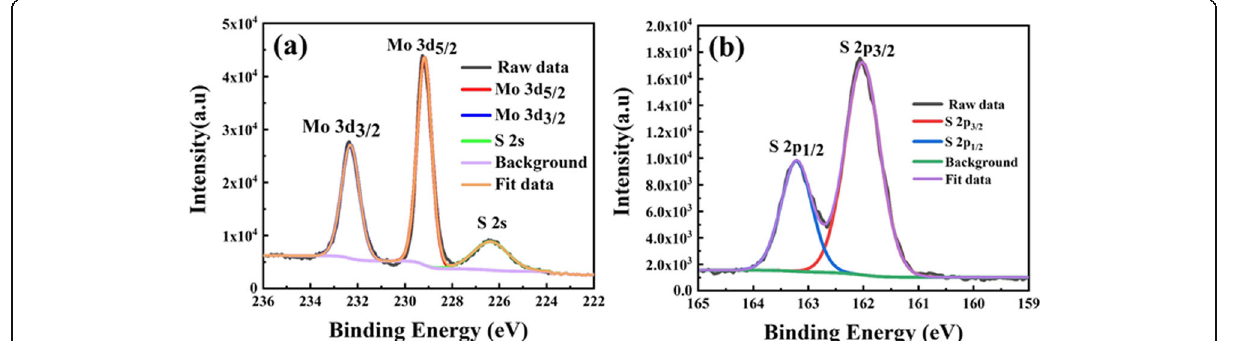
Fig. 3 XPS survey spectra of a Mo 3 d and b S 2 p of the exfoliated MoS 2 nanosheets